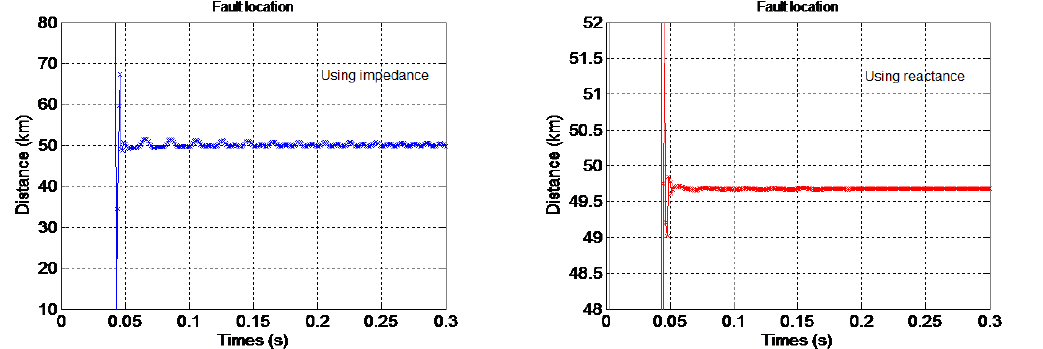
Fig. 7: Fault location as function of time using the impedance.